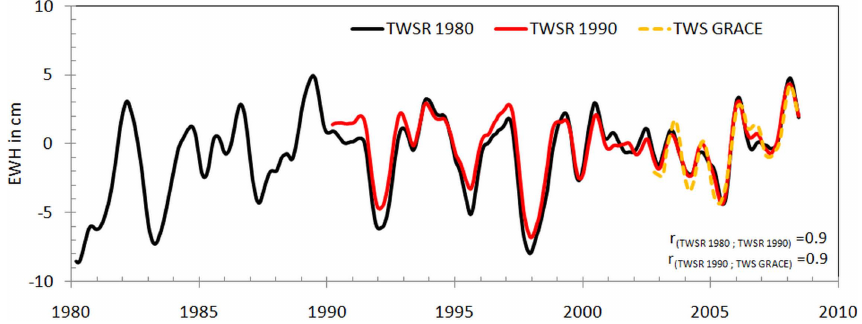
Fig. 6. Basin-averaged of the TWSR. The basin-averaged of the TWSR over 1980–2008 is the black line. The basin-averaged of the TWSR over 1990–2008 is the red line. The TWS GRACE data is superimposed in dot line over 2003–2008. We filtered out the high frequencies using a simple 5-month running mean. r is the correlation coefficient (with a significance level higher than 99%).